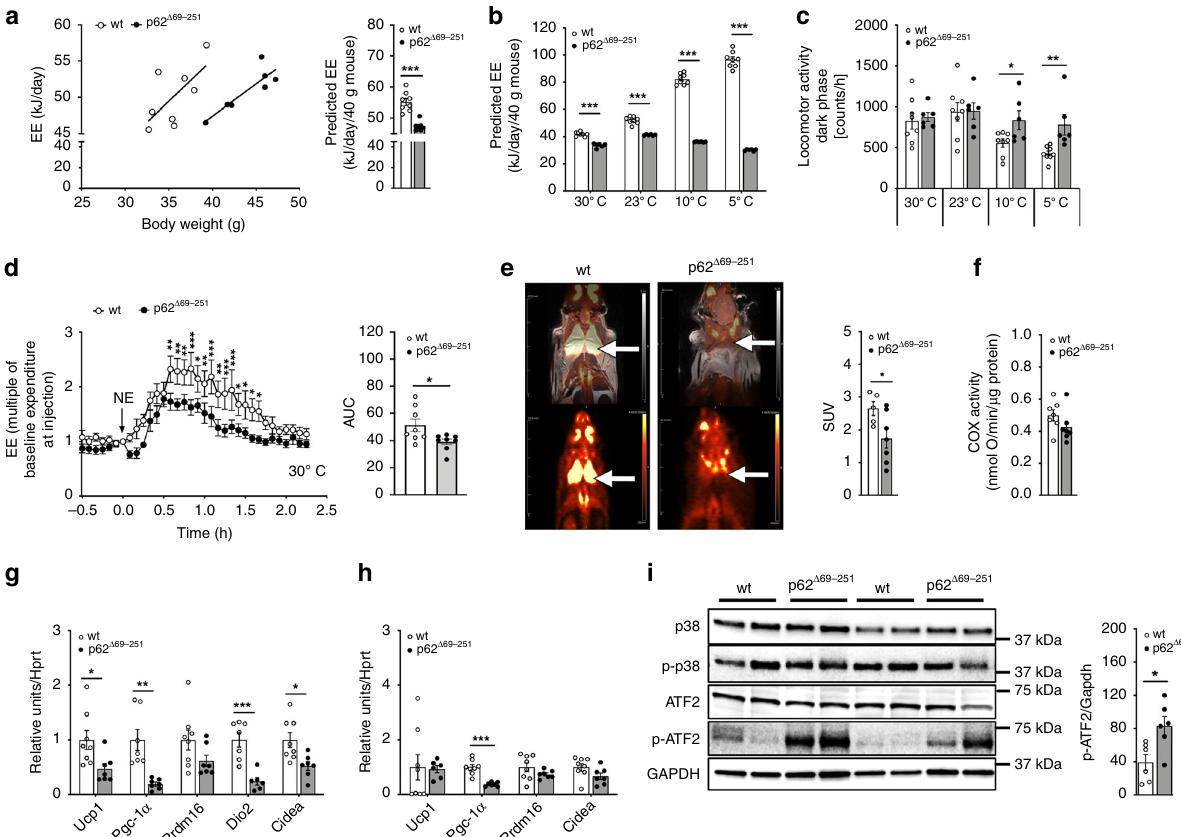
Fig. 2 Impaired energy expenditure and BAT thermogenesis in obese p62 Δ 69-251 mice. Energy expenditure (EE) plotted against body weight and ANCOVA predicted energy expenditure at a given body weight of 40 g in obese 32-wk-old male C57Bl/6J wt or p62 Δ 69-251 mice fed a regular chow diet. When considering body weight as covariate, the ANCOVA genotype effect is p = 0.016 ( a ). Predicted energy expenditure ( b ) and locomotor activity during the dark phase ( c ) of 26-wk-old male mice at different environmental temperatures. Energy expenditure of male mice during a norepinephrine (NE) challenge at 30 °C ( d ). PET/MRI imaging of male 8-mths-old male mice with standardized uptake values (SUV); white arrow indicates location of BAT ( e ). Cytochrome c oxidase (COX) activity normalized to protein concentration ( f ), thermogenic gene expression pro fi ling in BAT ( g ) and iWAT ( h ), and protein levels of p-p38, p38, ATF2, p-ATF2 (Thr69/71), and GAPDH ( i ) in BAT of obese 33-wk-old male mice. Samples sizes are ( a ) n = 8/7 mice, ( b , c ) n = 8/6 mice, ( d ) n = 8/8 mice, ( e ) n = 5/7 mice, ( f ) n = 7/7 mice, ( g ) Ucp1 n = 8/7 mice; Pgc-1 α n = 7/7 mice, Prdm16 n = 8/7 mice, Dio2 n = 7/6 mice, Cidea n = 8/7 mice, ( h ) Ucp1 n = 8/6 mice, Pgc-1 α n = 8/7 mice, Prdm16 n = 8/7 mice, Cidea n = 8/7 mice, ( i ) representative western blot of n = 4 (out of n = 6) p62 wt and n = 4 (out of n = 6) p62 Δ 69-251 mice and quanti fi cation of pATF2/GAPDH in n = 6 mice each genotype. The full blot with n = 6 mice each genotype is provided in the Source data fi le. Data represent mean ± SEM. Data in panels ( a ) and ( b ) were analyzed using ANCOVA using body weight as covariate. Bar graphs in panels ( a ), ( b ), ( c ), ( e ), ( f ), ( g ), ( h ), and ( i ) were analyzed using two-side two-tailed t -test. Data in ( d ) were analyzed using two- way ANOVA using time and genotype as covariates and with Bonferroni post hoc multiple comparison test for each individual time-point. * p < 0.05; ** p < 0.01; *** p < 0.001. Exact p -values are given in the Source data fi le. Hprt hypoxanthine guanine phosphoribosyltransferase, Prdm16 PR/SET domain 16, Cidea cell death-inducing DNA fragmentation factor alpha subunit-like effector A, Dio2 deiodinase 2, GAPDH Glyceraldehyde-3-phosphate